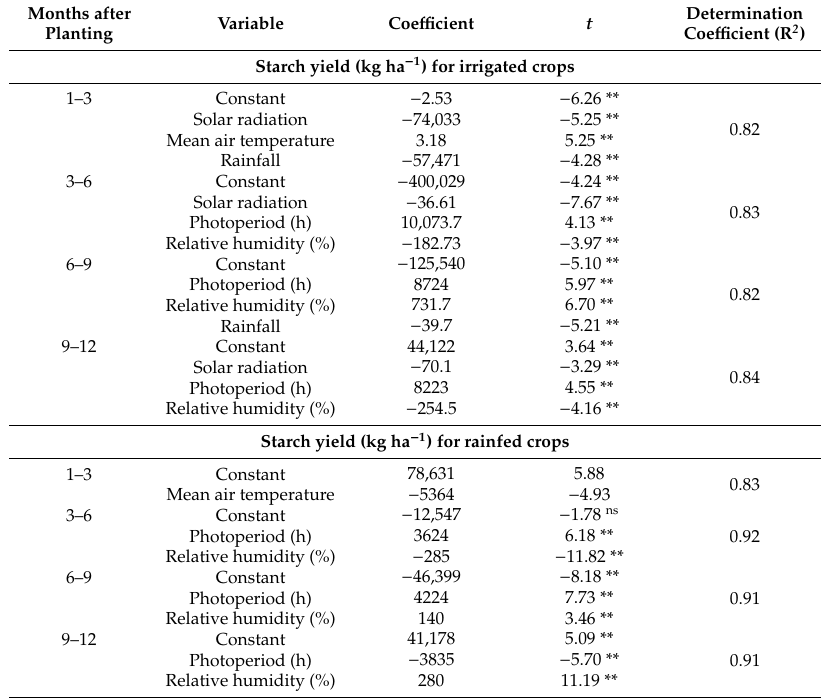
Table 7. The stepwise regression analysis for the starch yield (kg ha − 1 ) and climatic factors of cassava cv. Rayong 9 for both irrigated and rainfed